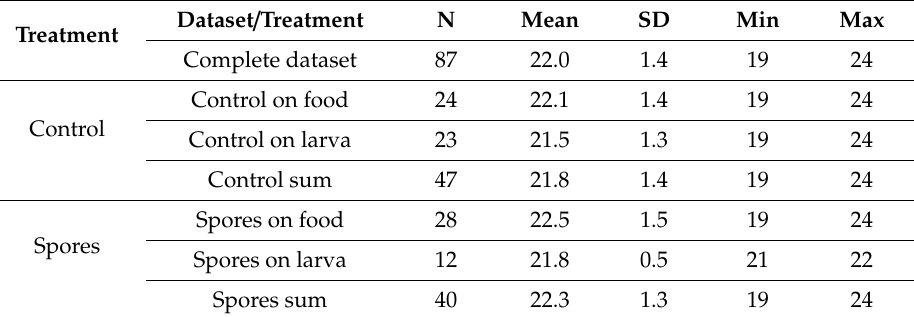
Table A4. Dispersion of dataset history for the set of pupation start.